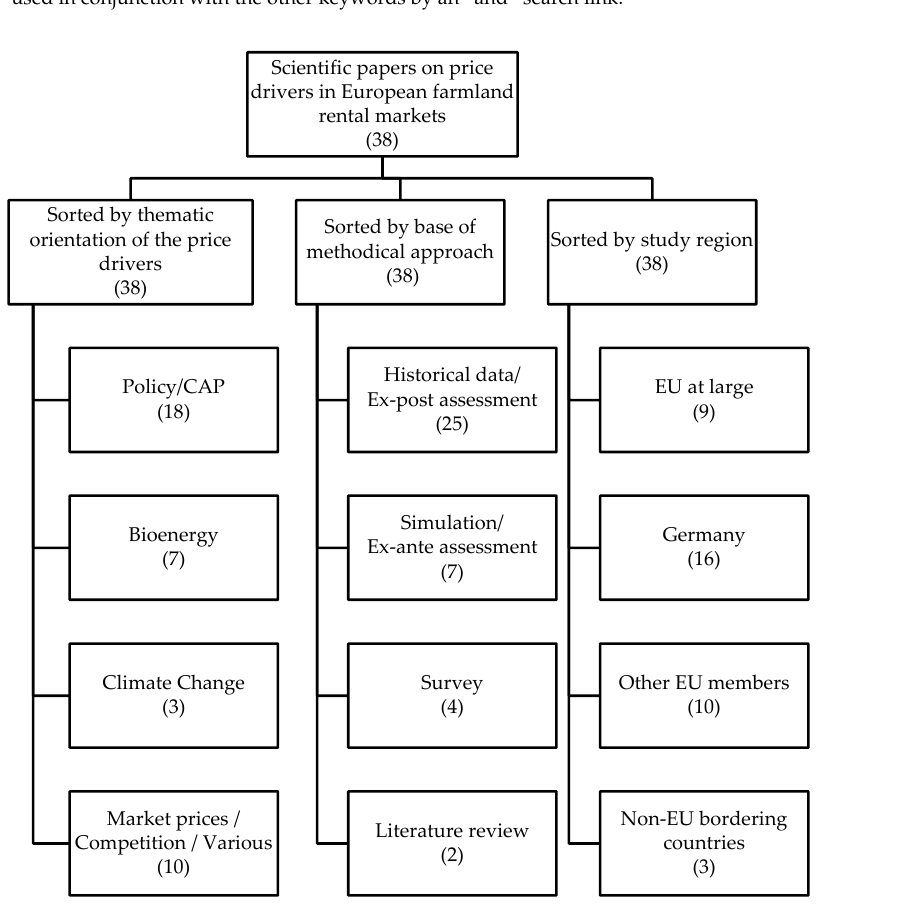
Figure 1. Thematic, methodological, and regional breakdown of the articles selected by preferred reporting items for systematic reviews and meta-analysis (PRISMA). CAP = Common Agricultural Policy; EU = European Union.